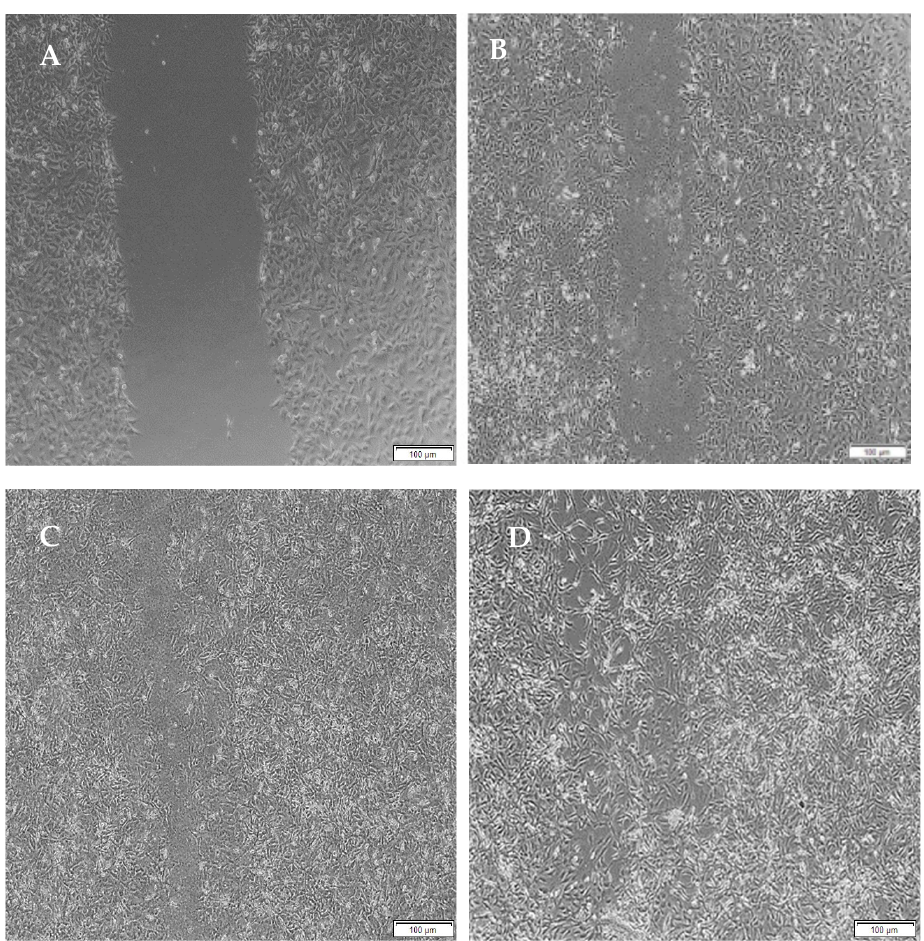
Figure 15. Micrographs of the migration of A172 cells from a wound-healing assay of the full IPN at ( A ) 0 h, ( B ) 8 h, ( C ) 24 h and ( D ) 48 h. Images were captured using the 4× objective and the phase contrast feature of an inverted light microscope. The red arrows indicate actively migrating cells at 8 h.